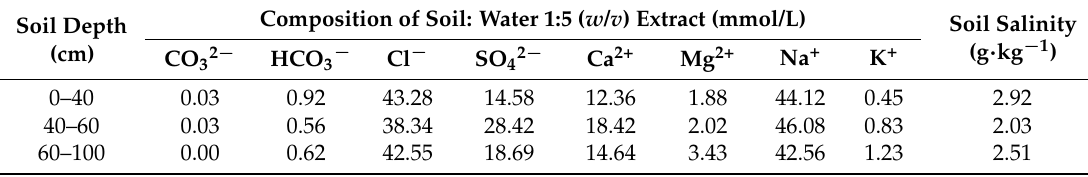
Table 3. Basic soil salinity of the initial